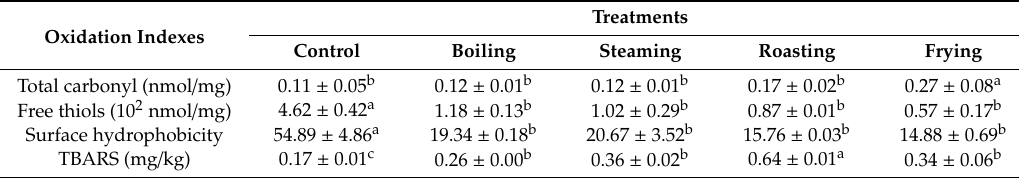
Table 2. The content of total carbonyl, free thiols, surface hydrophobicity and thiobarbituric acid reactive substances (TBARS) in Spanish mackerel muscle before (control) and after boiling, steaming, roasting and frying.